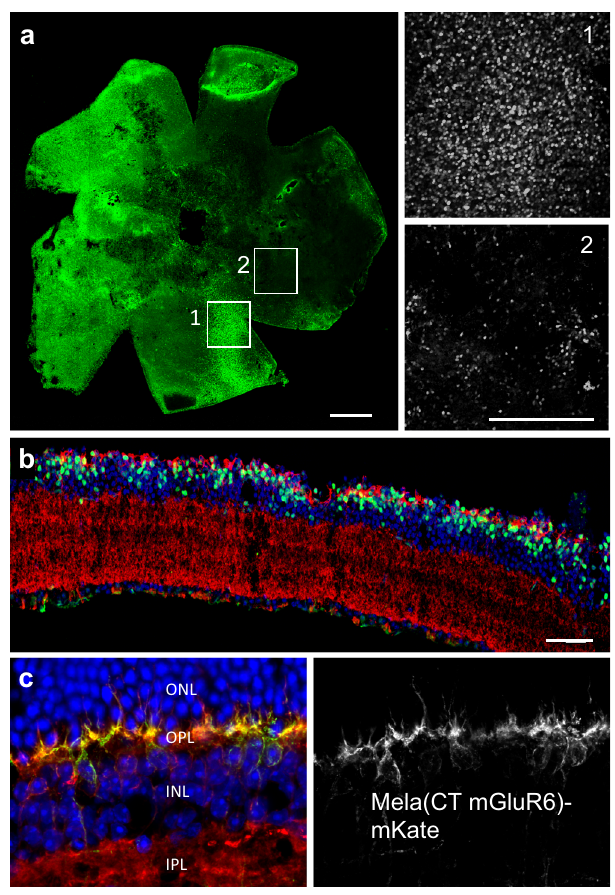
Fig. 2 Targeted expression in OBCs after intravitreal injection. a A representative rd1 retina four weeks after intravitreal injection of Mela(CTmGluR6)-IRES-TurboFP635. Inserts show higher magni fi cation scanning micrographs taken from the bipolar cell layer at speci fi ed regions, with relatively high (1) or low (2) transduction. Despite the highlighted heterogeneity, OBCs were transduced across the retina. b Expression was speci fi c for OBCs in the rd1 retina (TurboFP635 in green; G α o in red; DAPI in blue). c A Mela(CTmGluR6)-mKate fusion protein demonstrates robust targeted expression to the OBC dendrites (mKate in green; G α o in red; DAPI in blue). Scale bars 500 µ m in ( a ) and 50 µ m in other